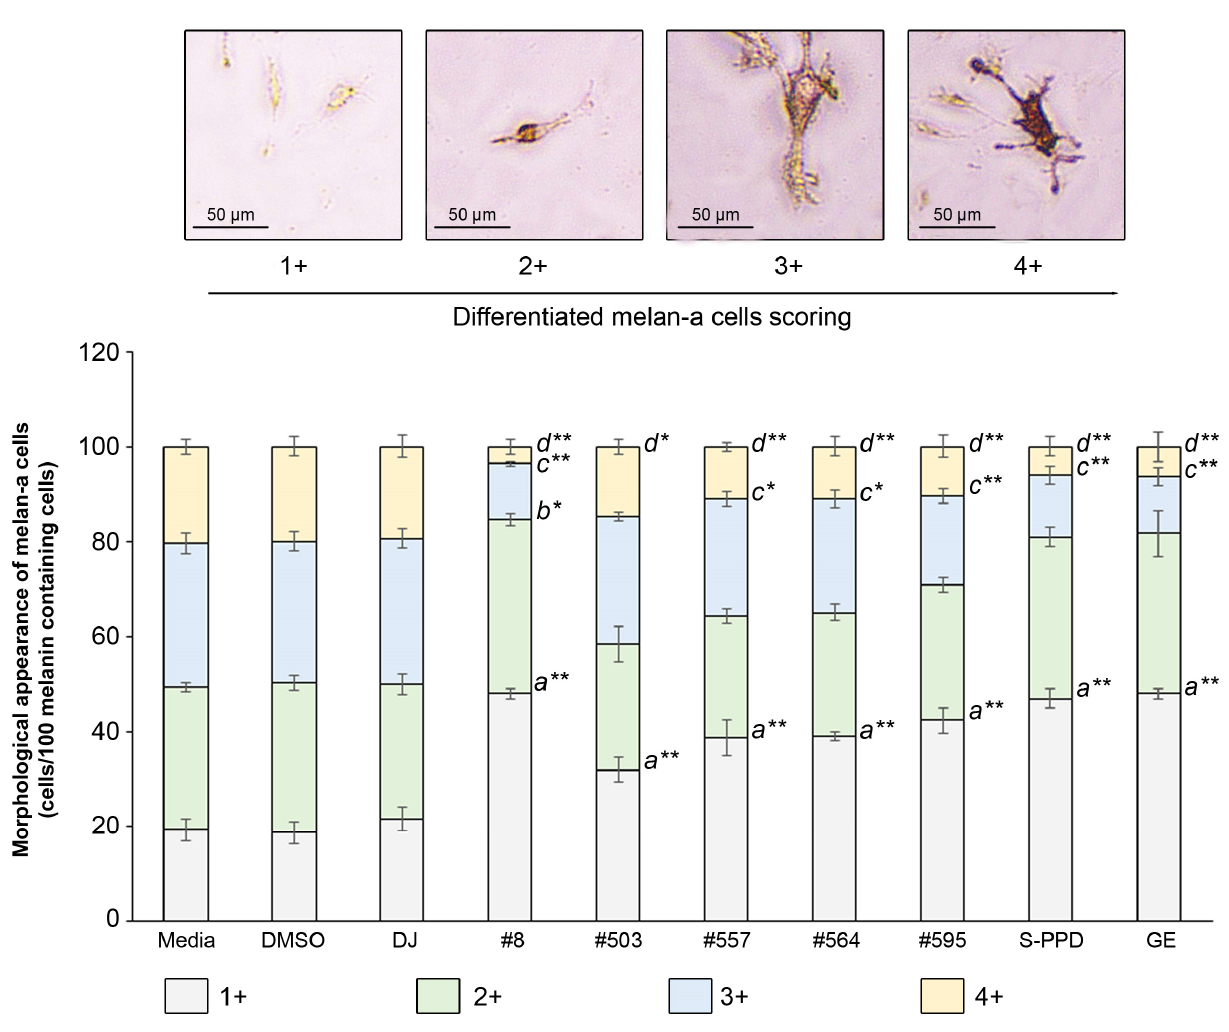
Figure 6. Effects of the PPD-enriched transgenic rice seed extracts on the morphological appearance of melan-a cells. The melanin-containing cells were 100 cells and divided into 4 groups based on their morphology. DJ, #8, #503, #557, #564, and #595 concentrations were 100 µg/mL. DMSO, S-PPD, and GE concentrations were 0.1%, 700 pg/mL, and 100 µg/mL, respectively. Data are shown as mean ± standard deviation ( n = 3). Lowercase letters indicate significant differences at p < 0.05 (*) and p < 0.01 (**) versus scores 1+, 2+, 3+, and 4+ of the media group.